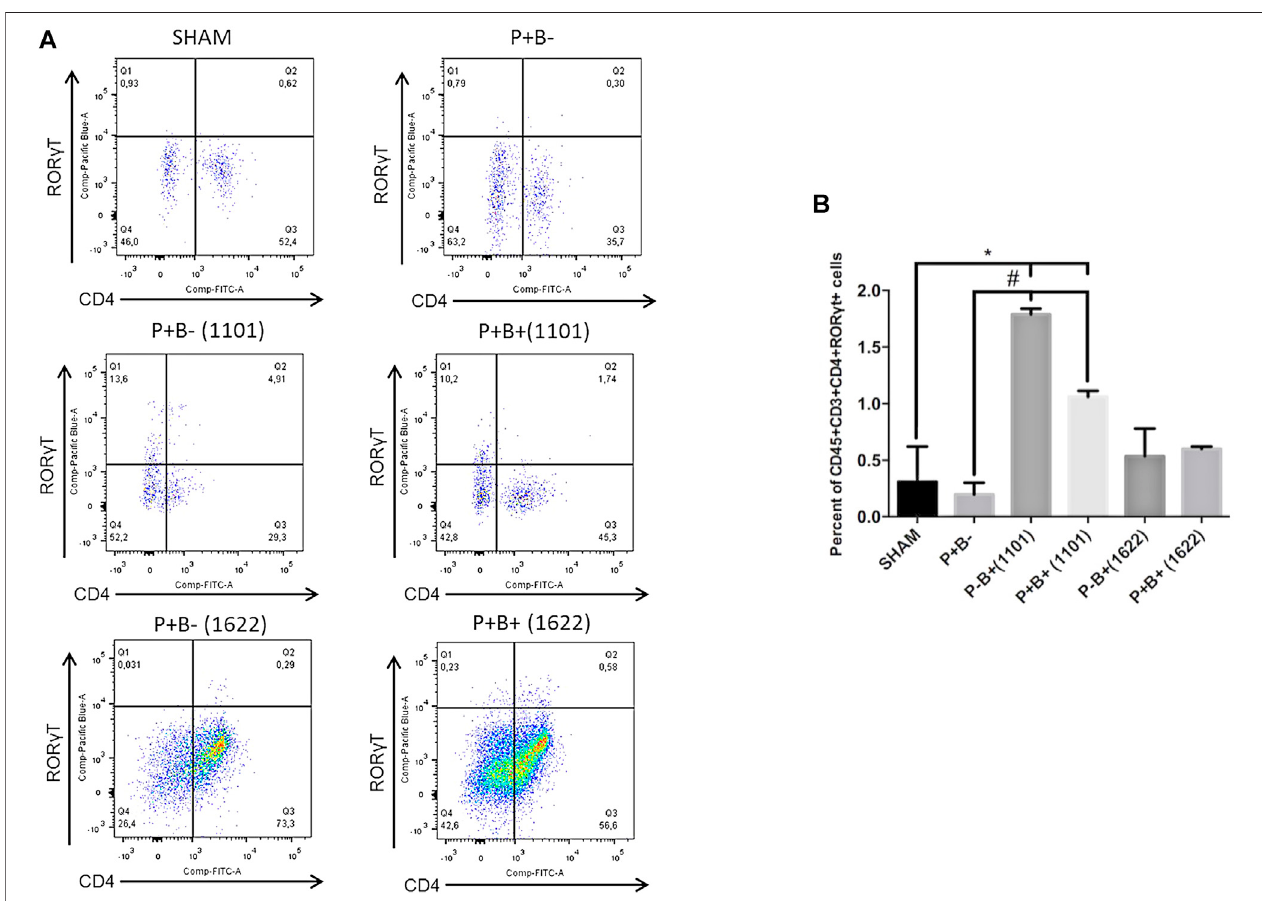
FIGURE5| Oraladministrationof B.breve 110 1A increasesTh17populationinthegingivaltissue.Th17population inthegingivaltissueofC57Bl/6micesubmitted to different treatments: SHAM (negative control), P + B- (microbial consortium), P-B+ (1101) ( B. breve 110 1A ), P + B+ (1101) (microbial consortium + B. breve 110 1A ), P-B+ (1622) ( B. bi fi dum 162 2A ) and P + B+ (1622) (microbial consortium + B. bi fi dum 162 2A ). In (A) representative fl ow cytometry diagram showing the gating of CD4 + , ROR γ t + Th17 cells. In (B) Average percentagesofCD4 + , ROR γ t + Th17 cells. *Statisticallysigni fi cant difference inrelation tonegativecontrol (SHAM),# Statistically signi fi cant difference in relation to positive control (P + B-). ANOVA, Tukey ’ s multiple comparison, p < 0.05%. Facs plots represent the results of one of two independent experiments with similar results ( n (cid:1) 2 pooled samples from 4 mice/per group).